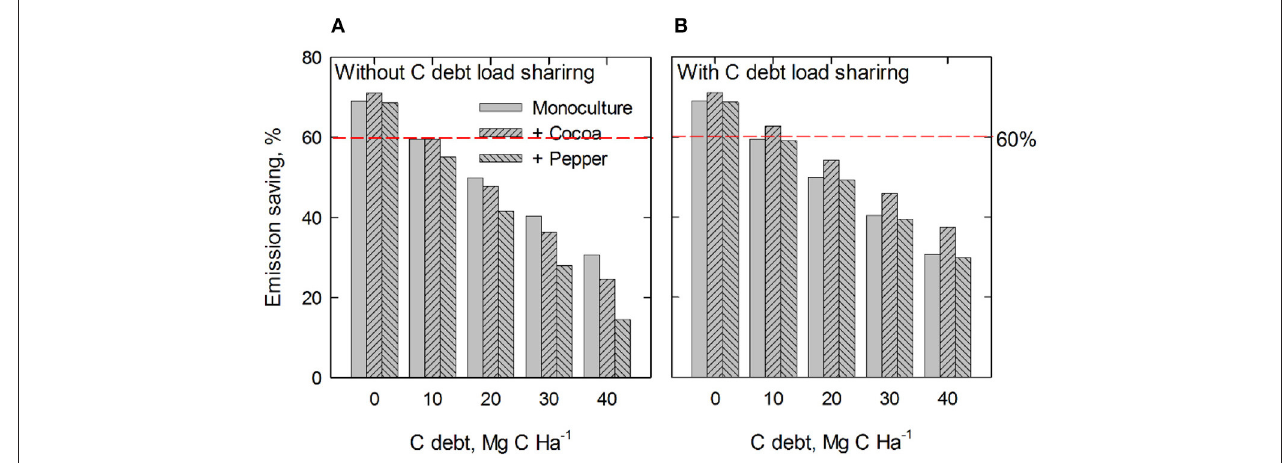
FIGURE 6 | Carbon footprint of palm oil when it is used as biofuel under different systems and various amount of C debt, without (A) , and with (B) sharing of the C debts over the intercropped trees. The carbon footprint is presented as saving emission (%) compared to the use of fossil